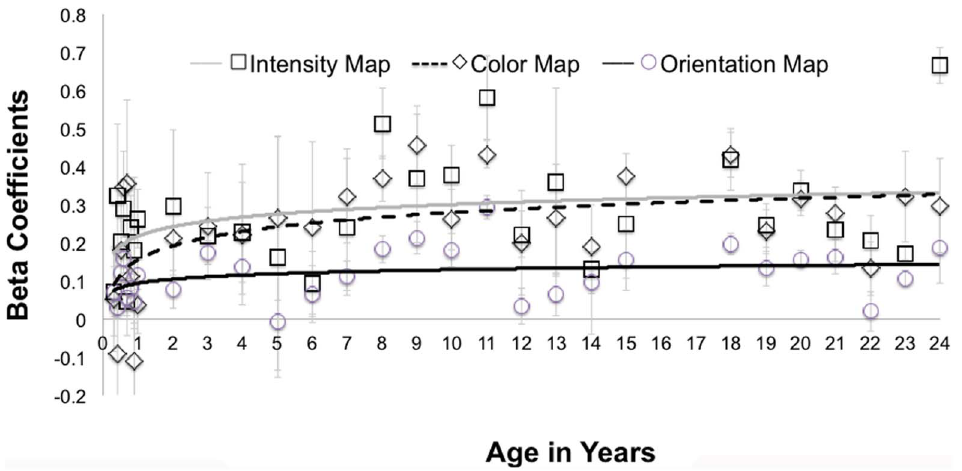
Figure 4. Illustrates beta coefficients for color, intensity, and orientation maps. Average beta coefficients are binned per month in participants less than one year of age, and per year subsequently. Standard error bars reflect variability within age